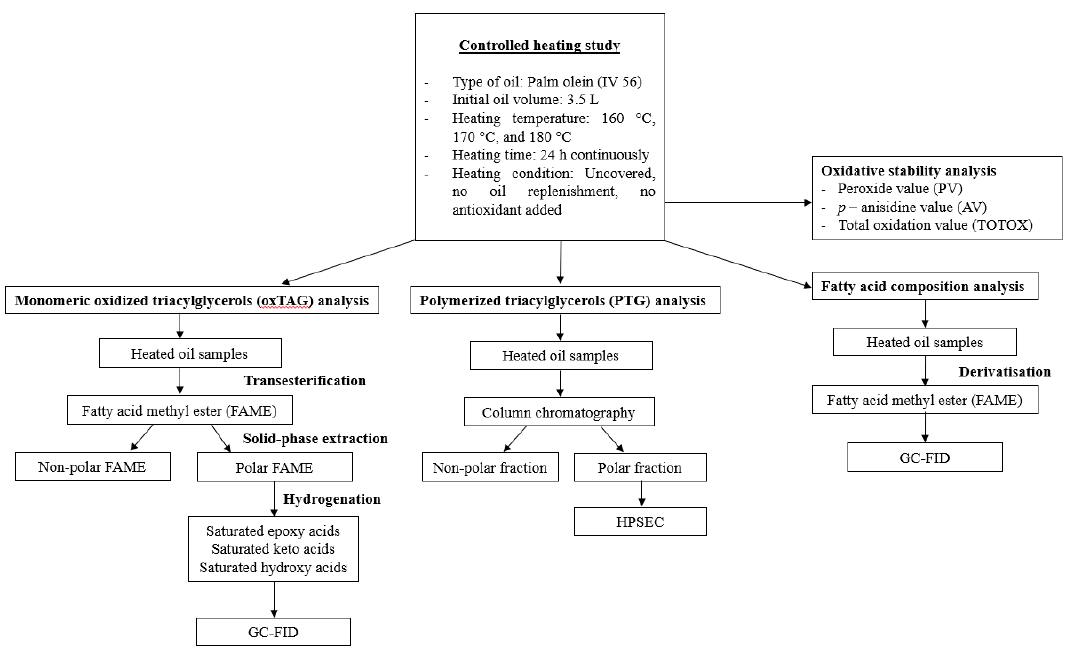
Figure 1. Flowchart of the experimental design. HPSEC: high performance size exclusion chromatography; GC-FID: gas chromatograph equipped with a flame ionization detector.